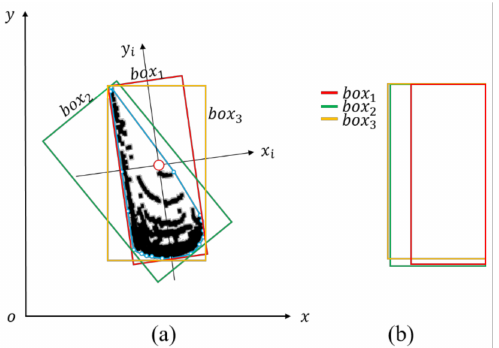
Figure 14. Illustration of the bounding box area evaluation index: ( a ) three different pose estimation bounding boxes; ( b ) a comparison of three bounding box areas. The area of box1 is the smallest, and the pose estimation of the two-dimensional bounding box is the most compact, which means its pose estimation result was the most